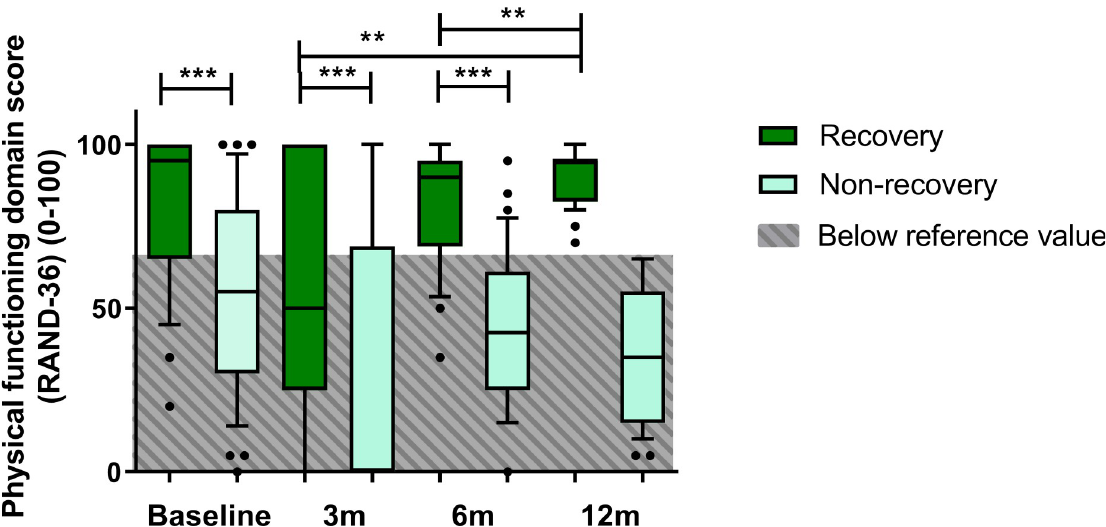
Fig 2. Course of physical functioning domain scores during the first year after ICU-admission for R-group and NR-group in boxplot with 10-90 th percentile whiskers. �� p � 0.01 ��� p < 0.001.